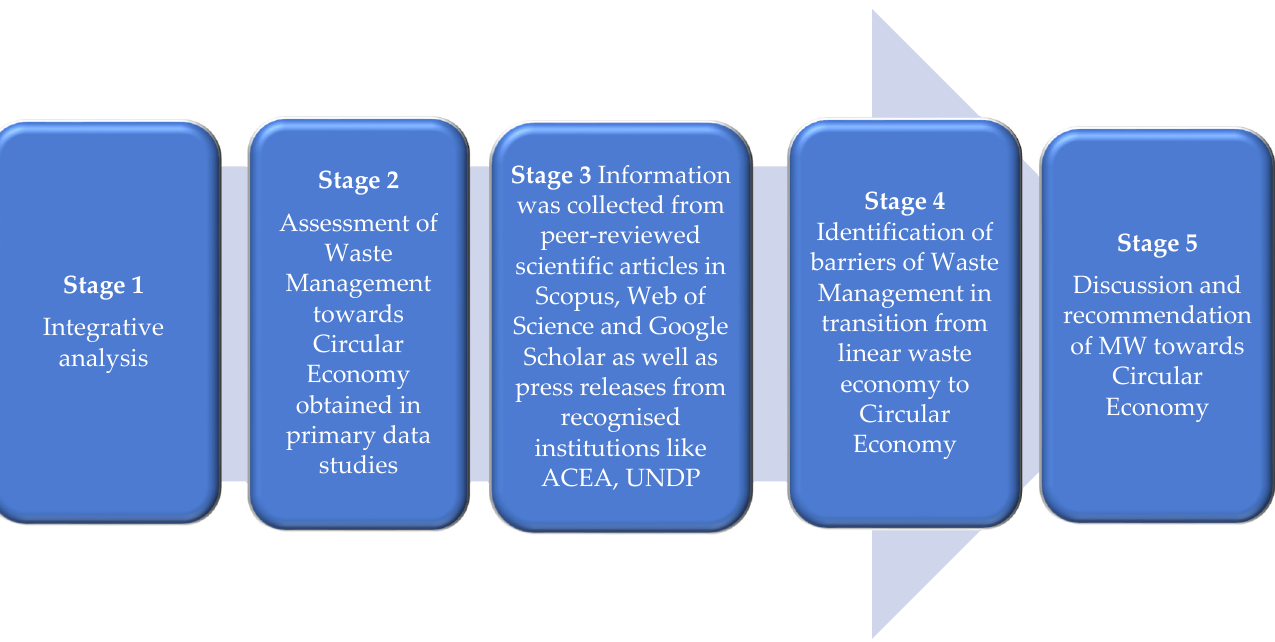
Figure 4. Integrative approach used in this study, adapted from Filho et al. [56].